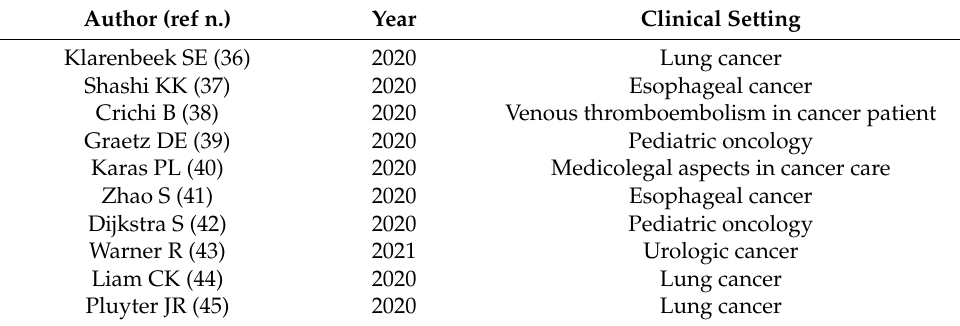
Table 6. The role of MDT meeting in cancer settings in recent literature. Author (ref